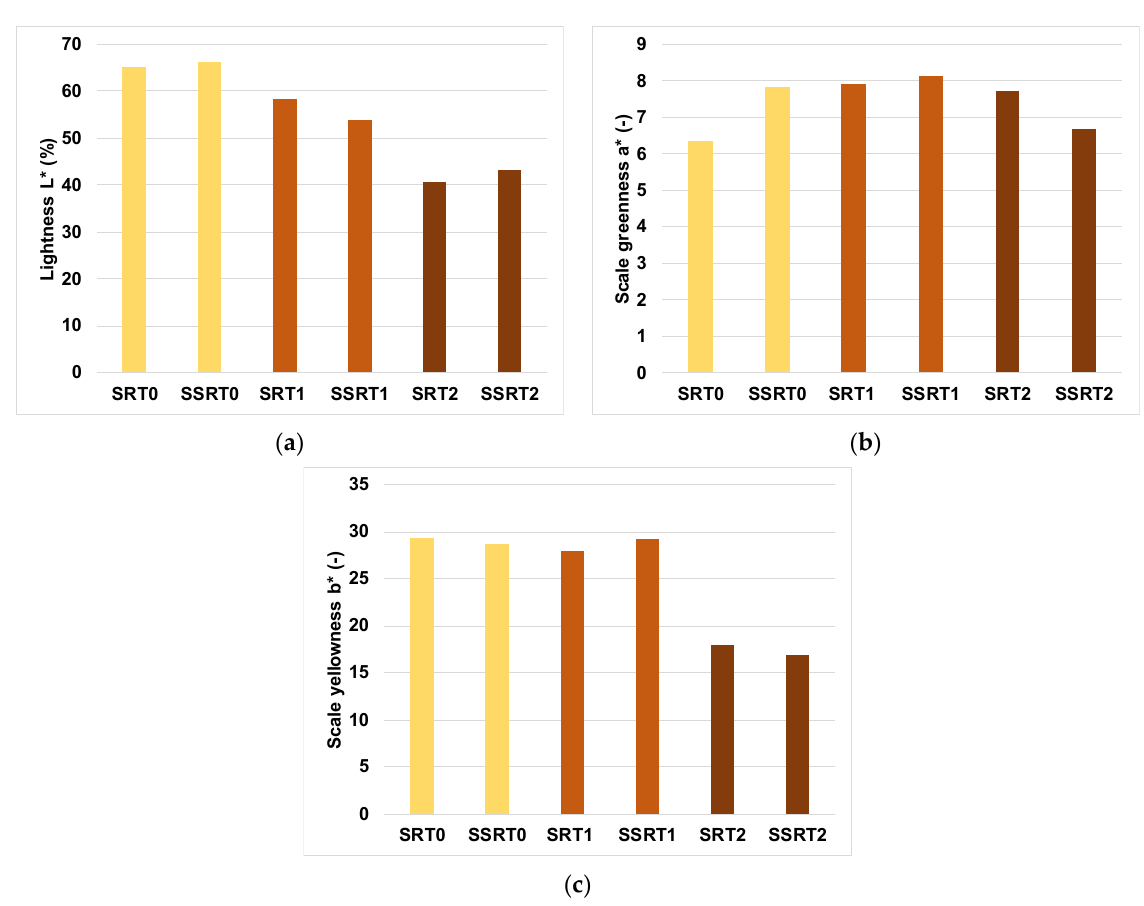
Figure 8. The colour measurement: ( a )the lightness; ( b ) the scale greenness a *; ( c ) the scale yellowness b *.